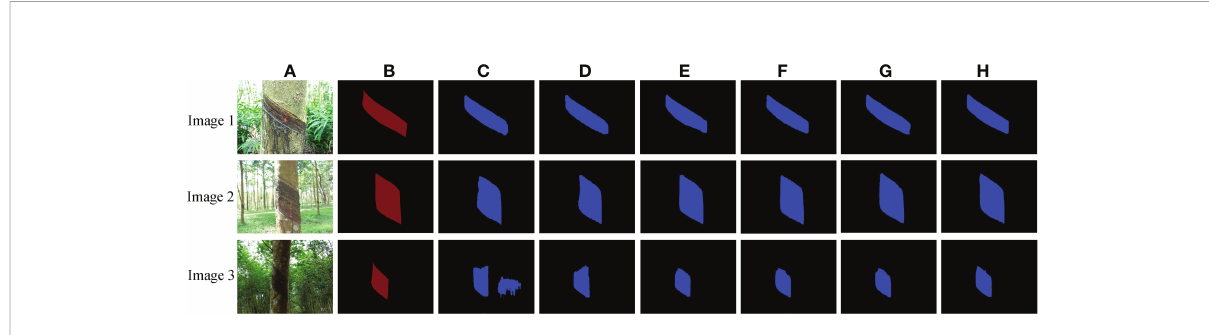
FIGURE 7 Tapped area segmentation results of natural rubber trees of different models. (A) Original images. (B) Label images. (C) MR(50). (D) MR(101). (E) IMRB(XA50). (F) IMRB(XA101). (G) IMRA(XA50+FC). (H)